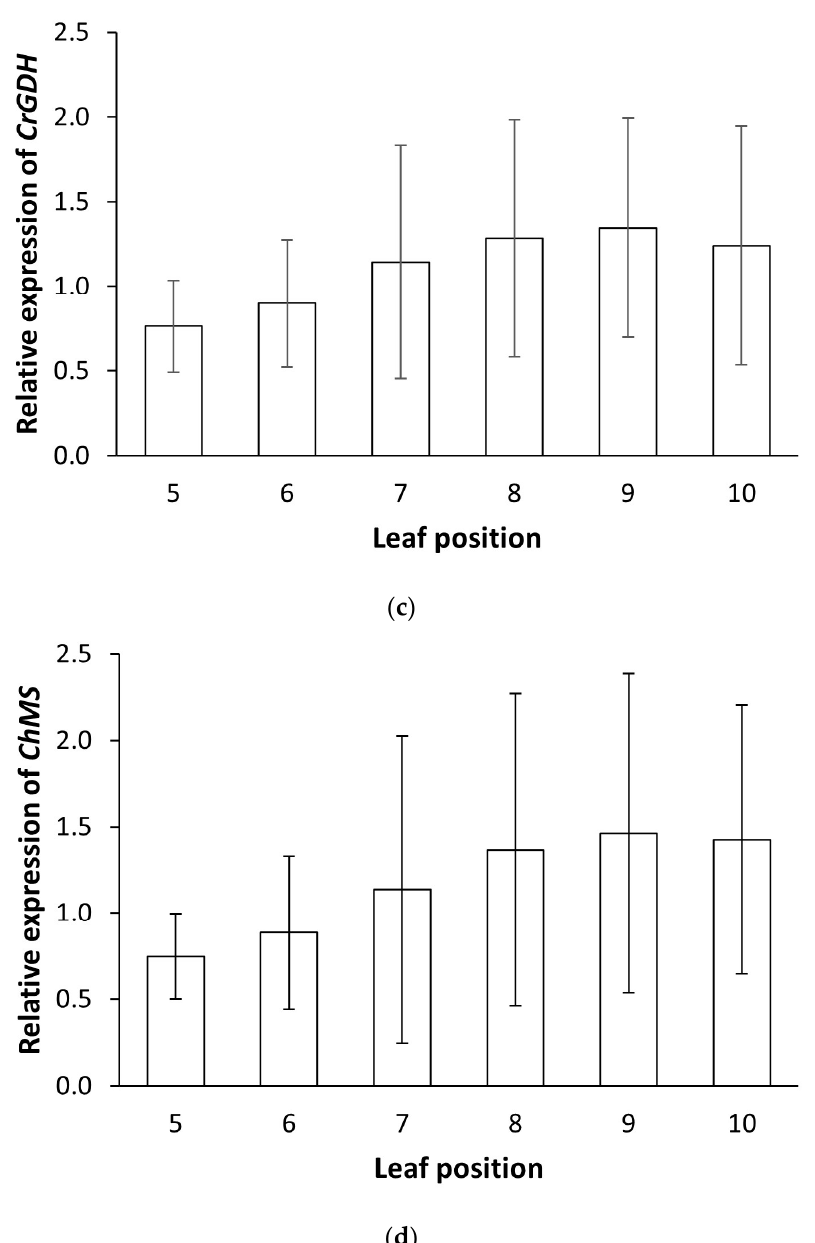
Figure 2. Gene expression variation in leaves of various developmental stages. Tissue samples were collected from leaves at each position of three ramets and processed separately. ( a ) Absolute Cq value of PtaPLGG1 (circle) and PtaAct (rhombus) from leaves of various positions on non-transgenic plant CT717 at Week 17. Two technical replicas were employed for the assay. For each reaction, 100 ng of total RNA was used. ( b ) The normalized relative expression level of PtaPLGG1 in various leaf positions of transgenic Event 13-15E and non-transgenic CT717, with the average expression levels of all leaves set as 1.0. ( c , d ) Normalized relative expression level of transgenes CrGDH ( c ) and ChMS ( d ) in transgenic Event 13-15E. The average expression levels of all leaves was set as 1.0. Reference gene used in this multiplex assay: PtaEF1B-1.